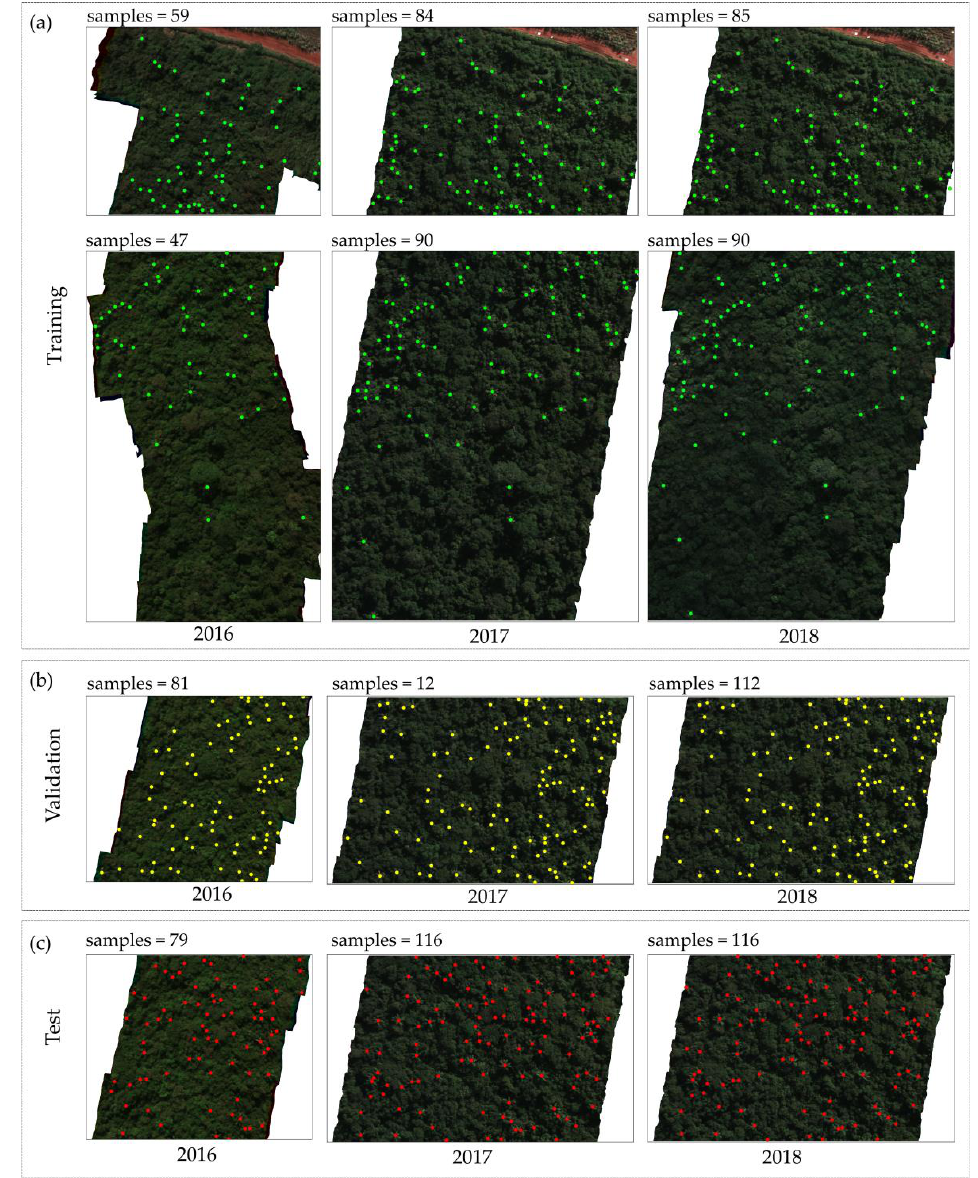
Figure 5. Image parts used for ( a ) training, ( b ) validation and ( c ) test. Table 2. Number of training, validation and test samples used in each experiment.